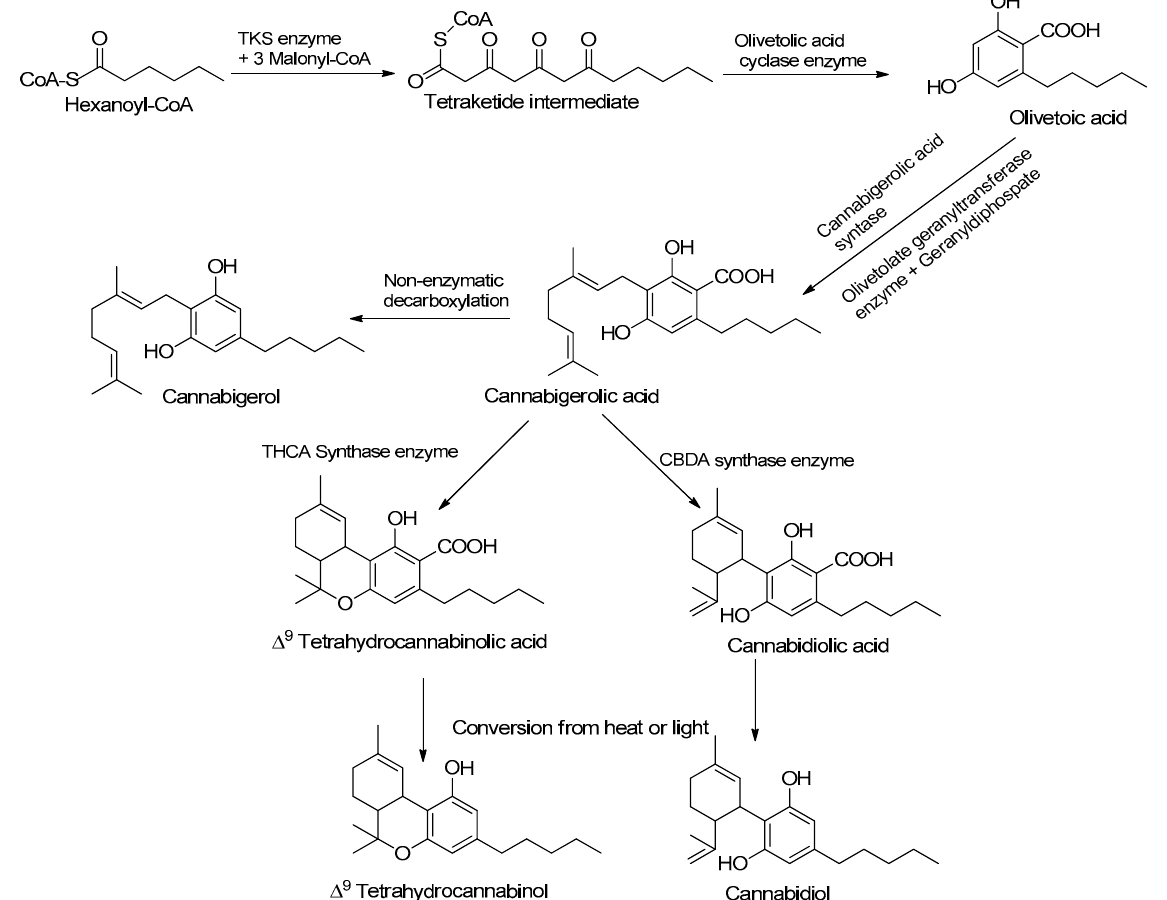
Figure 2. Cannabinoid biosynthetic pathway, leading to the two major phytocannabinoids, THC and CBD.